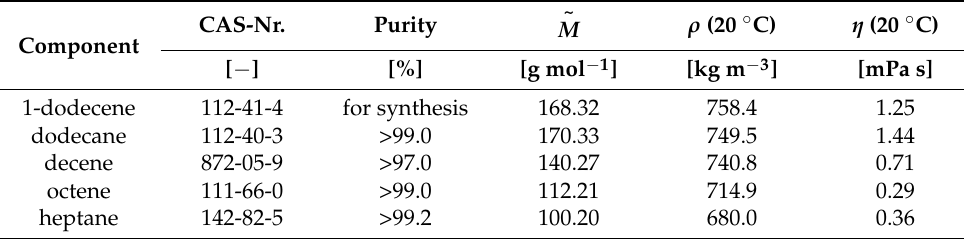
Table 1. Characteristic properties of the organic solvents used in this study. Molar masses and densities were taken from [19]. Dynamic viscosities were measured as described in Section 2.3. ~ CAS-Nr. Purity M Component 1-dodecene 112-41-4 for